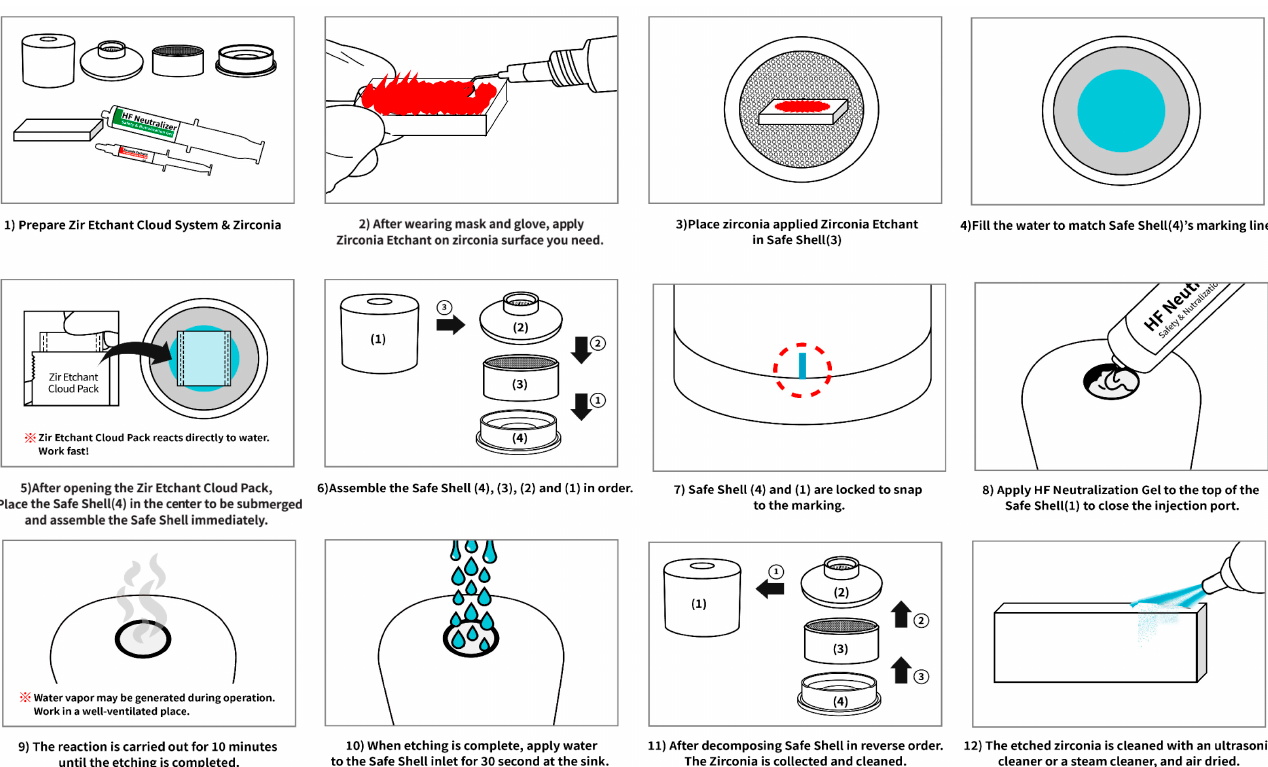
Figure 1. HF hot-etching procedure of the Zirconia Etchant Cloud System. Grouping of specimens is schematically shown in Figure 2.